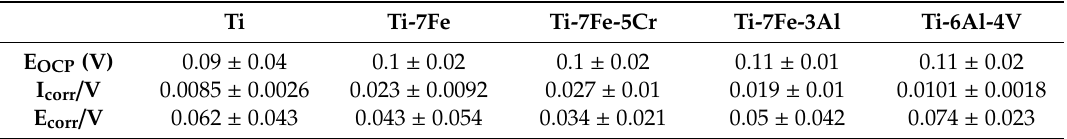
Table 7. Corrosion parameters of potentiodynamic polarization alloys in Harrison solution at room temperature